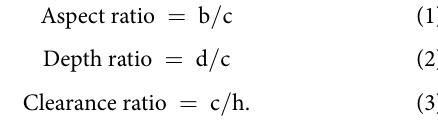
Frontiers in Built Environment |